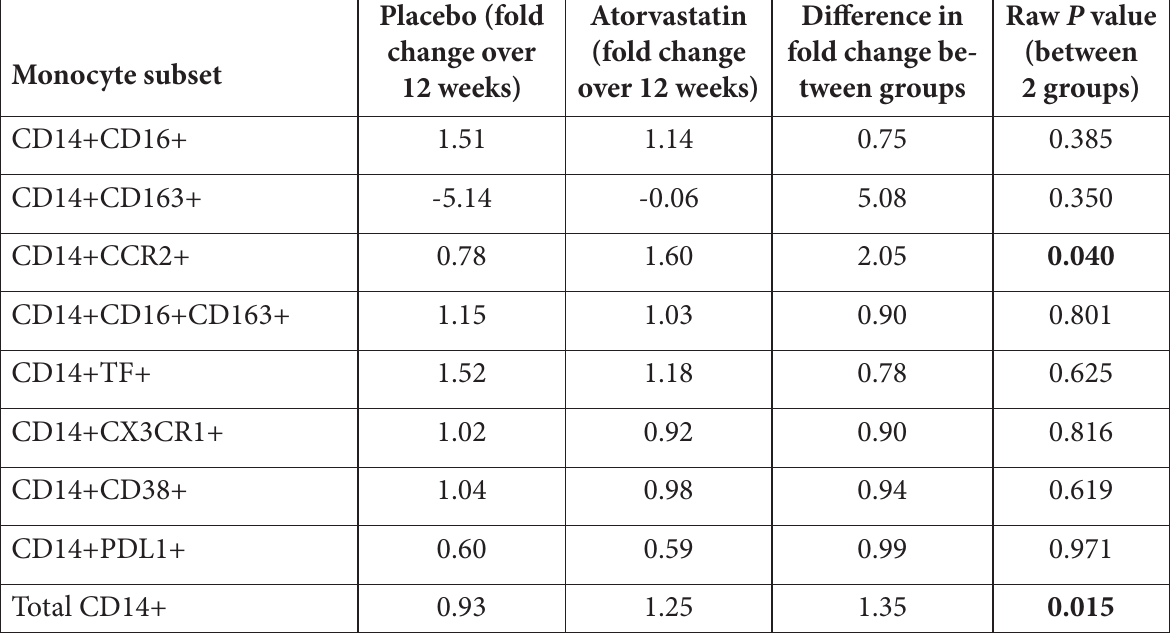
Table 2. Change in monocyte subsets over 12 weeks of atorvastatin or placebo